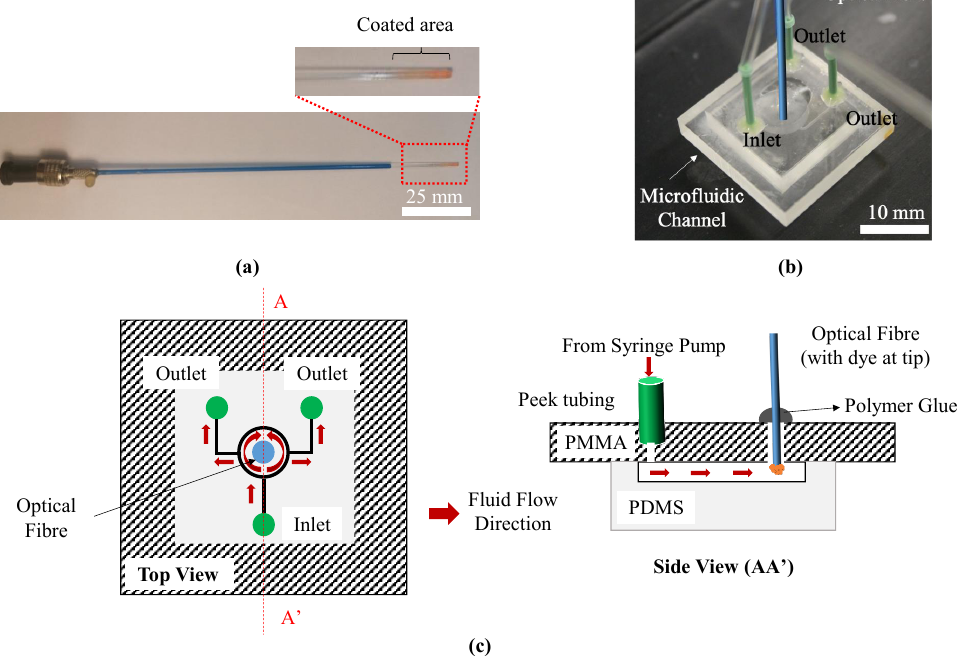
Figure 2. ( a ) Coated multimode fibre with a core diameter of ~1 mm. Inset shows a magnified ver- sion of the coated area. The coated area is fully inserted into the sensing chamber. ( b ) Fibres sealed in the microfluidic channel. ( c ) Top and side schematic view.